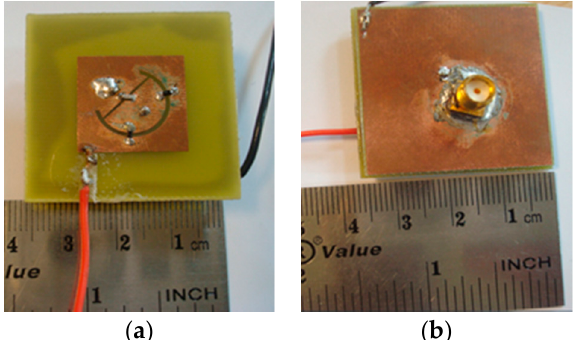
Figure 3. A photo of the fabricated antenna on a single FR-4 substrate. The red wire for (1 V) and black wire for (0 V) are used to control the diode states: ( a ) Top view; ( b ) Bottom view.